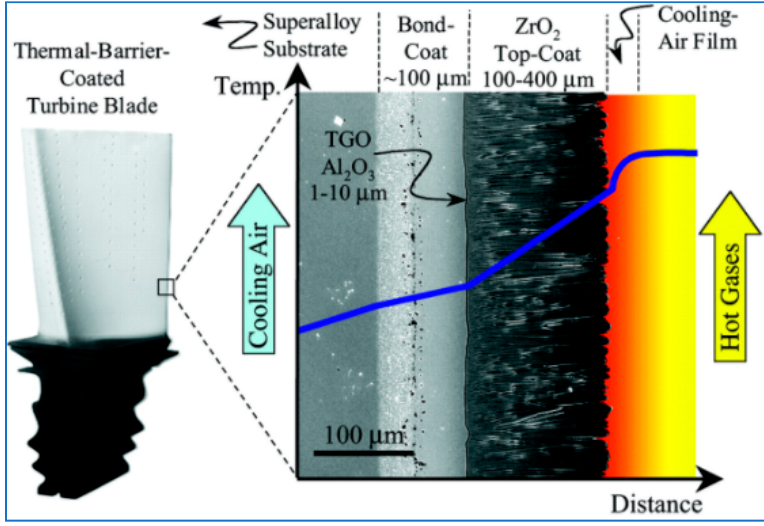
Figure 2. Cross-sectional SEM micrograph of an electron-beam physical-vapor-deposited (EB-PVD) thermal barrier coating (TBC) superimposed onto a schematic diagram showing the temperature reduction provided by the TBC. The turbine blade contains internal hollow channels for air-cooling, whereas the outside hot-section surface is thermal barrier coated, setting up a temperature gradient across the TBC. (1) TBCs for Gas-Turbine Engine Applications . Available from (accessed 1 June 2018). [6].